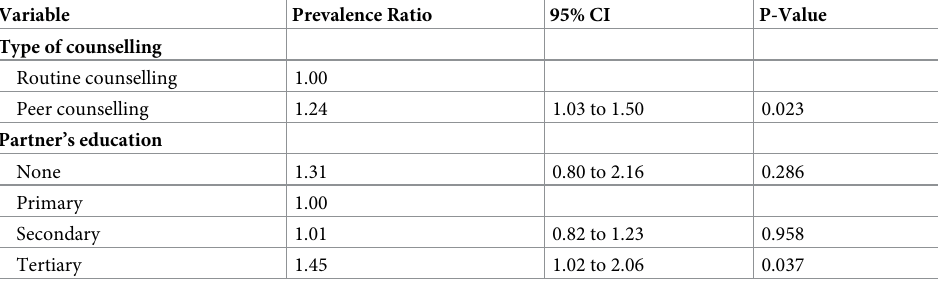
Table 4. Multivariate analysis of the factors associated with same day acceptance to use modern